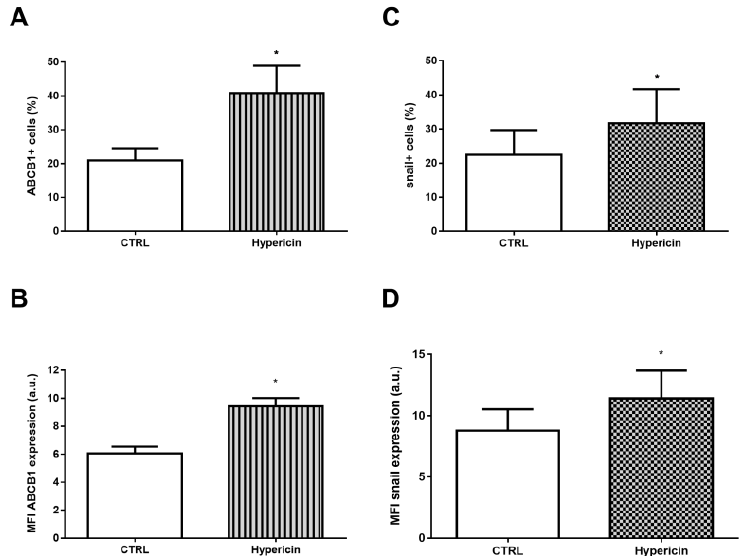
Figure 5. Hypericin increases ABCB1 and snail expression. A549 cells (1 × 10 5 cells/mL) were incubated with 1.5 µ M hypericin for ABCB1 expression induction. After 48 h, the cells were stained with ( A , B ) anti-ABCB1 or ( C , D ) anti-snail antibodies and ( A , C ) percentage of positive cells and ( B , D ) protein expression were evaluated by flow cytometry. Expression is represented by median fluorescence intensities (MFI). Bars represent mean + SEM, and the values of significance were represented by (*) for p < 0.05 from at least three independent experiments.